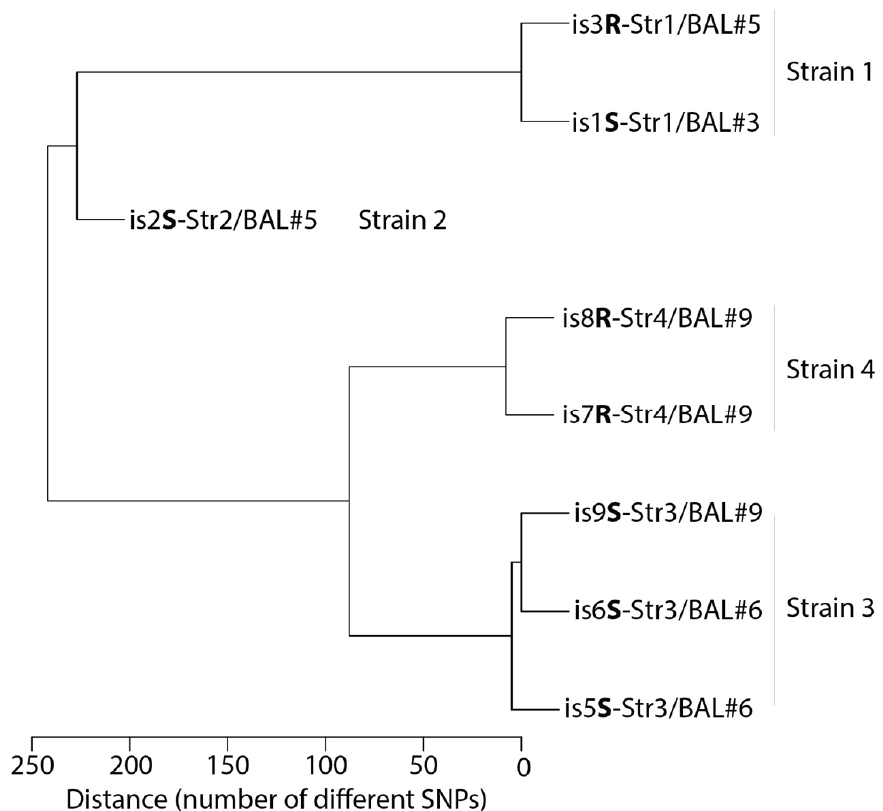
Figure 1. Phylogenetic tree built with Whole genome sequences of eight Achromobacter xylosoxidans strains isolated in a 12-year-old boy after double lung transplantation. The distance between samples reflects the number of different Single Nucleotide Polymorphisms (SNPs). Each A. xylosoxidans is named as follows: isolate number (is1 to is8) S (or R to depict susceptibility or resistance to phage cocktail)-Strain number/Number of BAL where it has been identified.